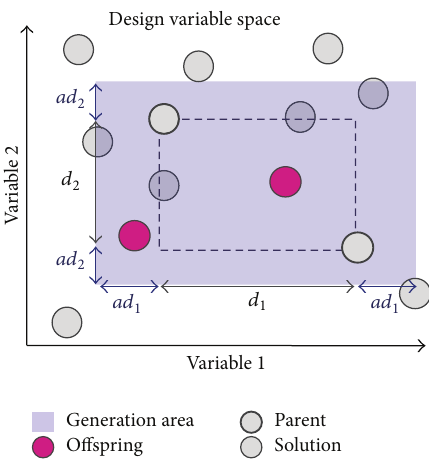
Figure 8: Process of generating offspring using the blend crossover